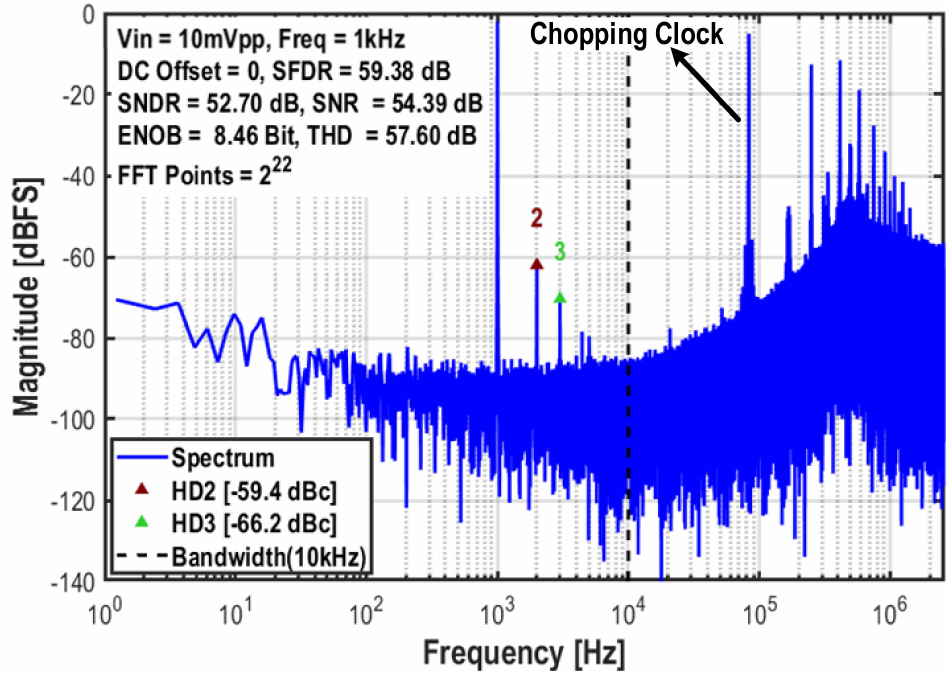
Figure 5. Measured PSD with 1 kHz sine input signal (single channel).